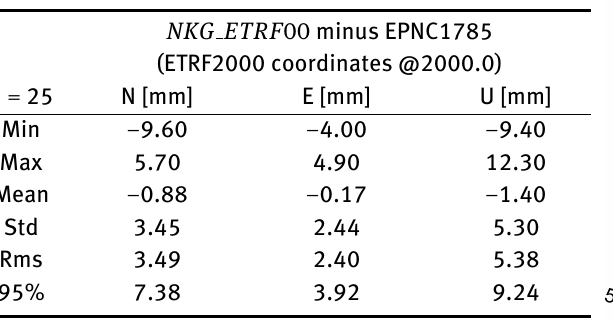
Table 4: Statistics of the common reference frame realization (co- ordinate differences to the EPNC1785 solution). Only stations in the land uplift area taken into account in the statistics.